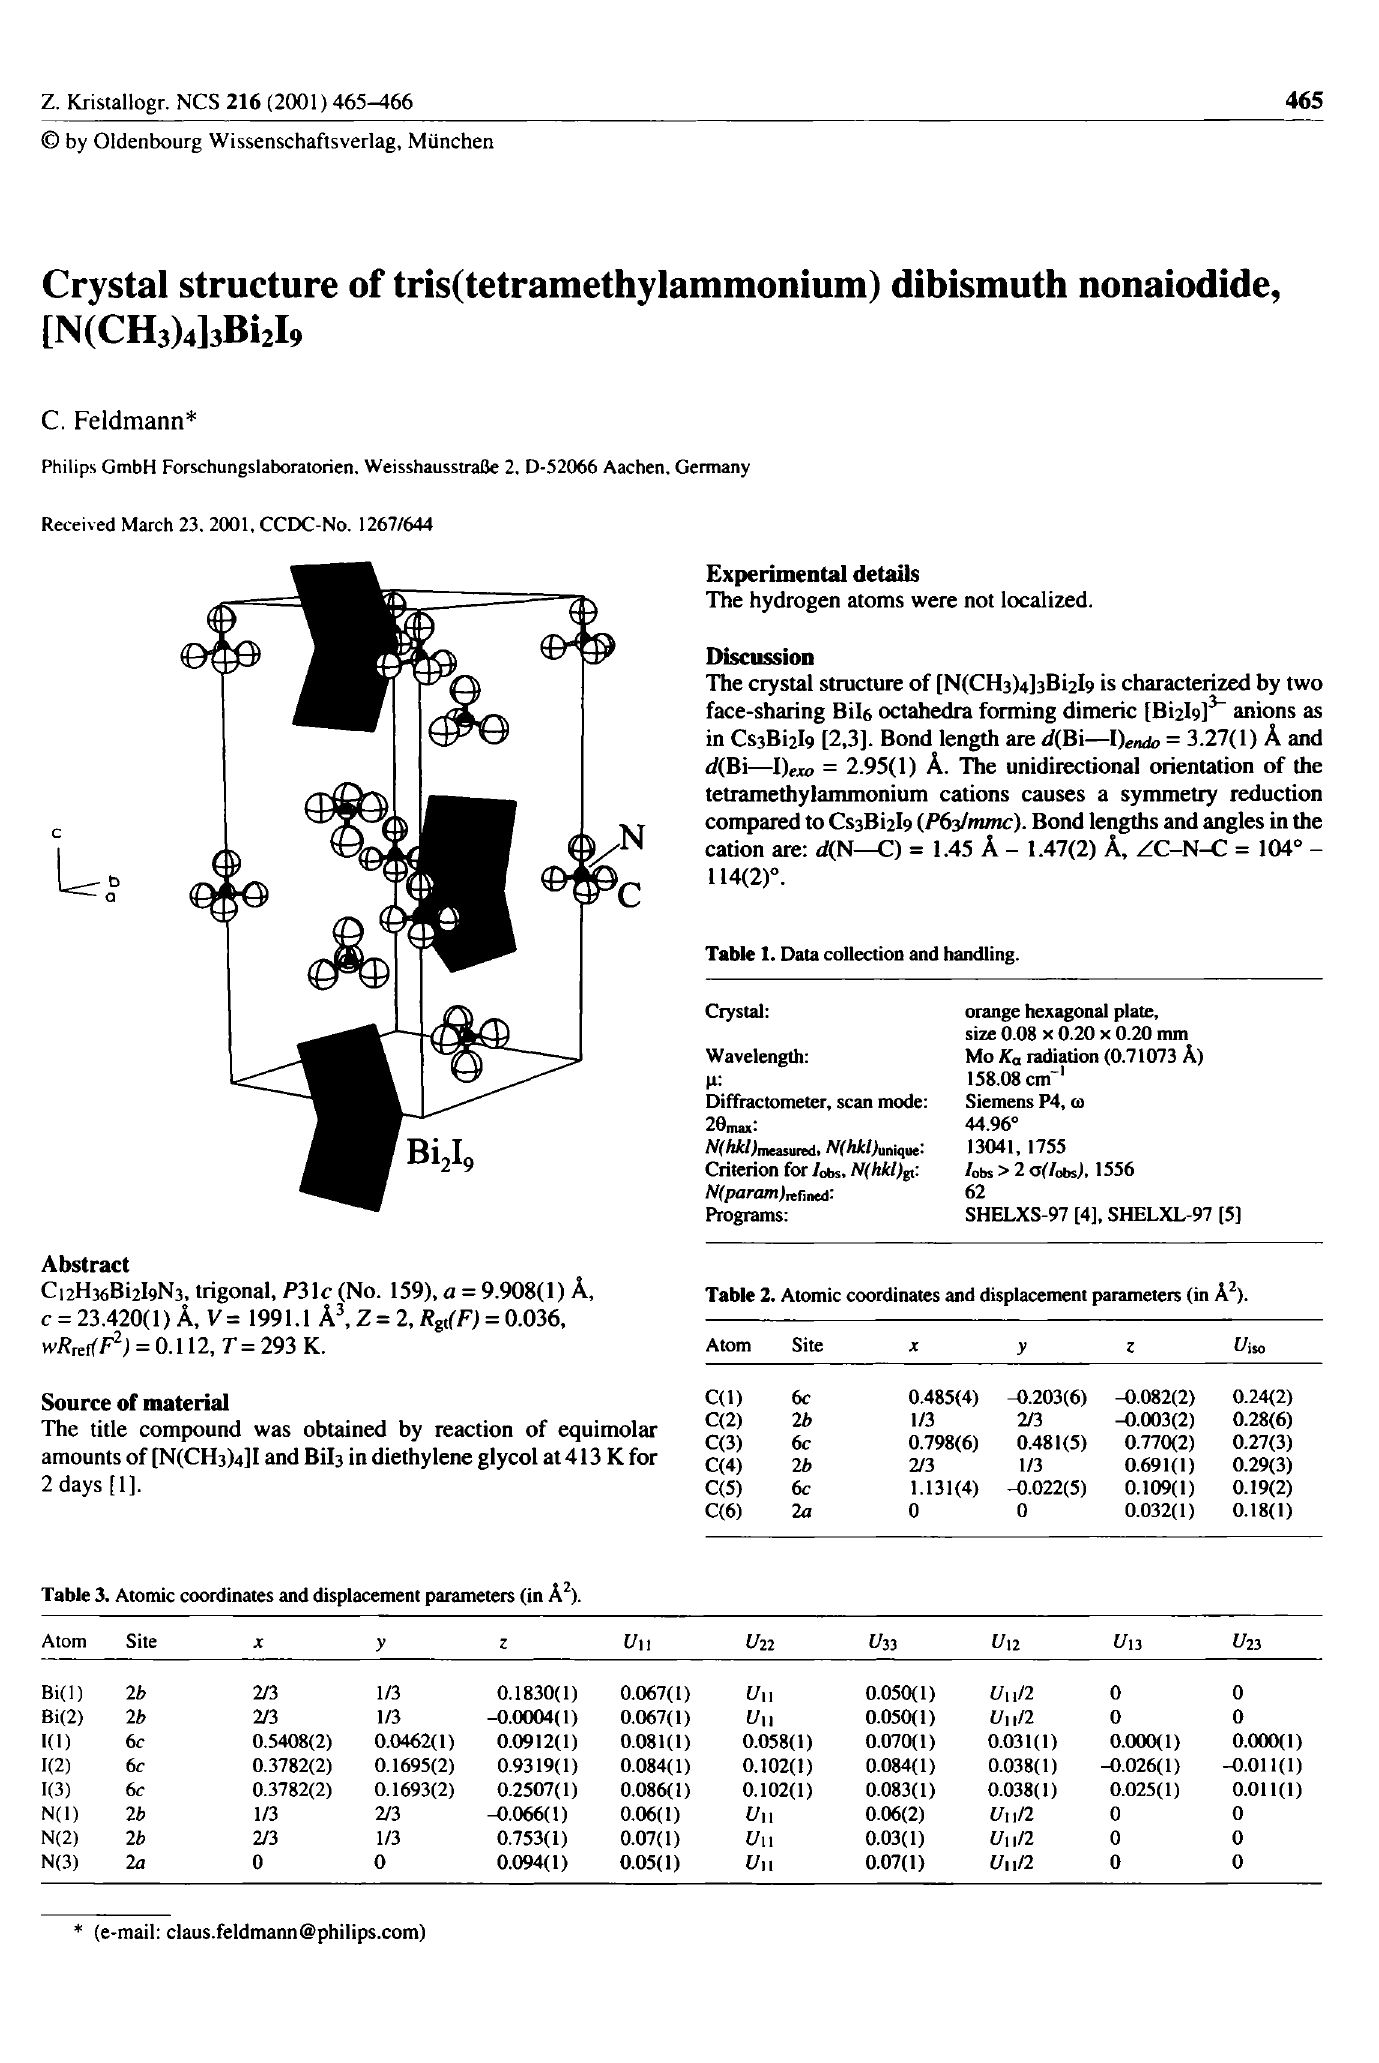
Table 3. Atomic coordinates and displacement parameters (in Ä 2